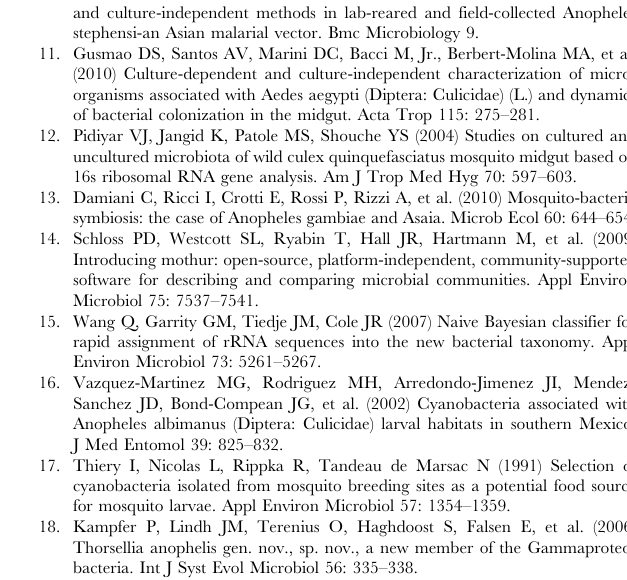
Figure S1 Sample collection scheme for field experi- ments in Kenya. Each box represents asample collection point. Figure S2 Bacterial abundance in mosquito guts before and after a blood meal. The relative abundance of 16S rDNA is presented as Mean 6 SD from three replicates. Sugar, sugar fed; PBM, post blood meal. Figure S3 Phylogenetic relatedness of representative bacterial species and mosquito gut bacteria based on 16S rRNA tag sequence similarity. Neighbor-joining tree is presented. Bootstrap values ( . 50) are given at nodes. Represen- tative bacteria are presented in bold fonts. Table S1 Similarity-based OTUs and species richness estimates. Table S2 Gut bacterial composition at phylum level across life stages of An.gambiae .